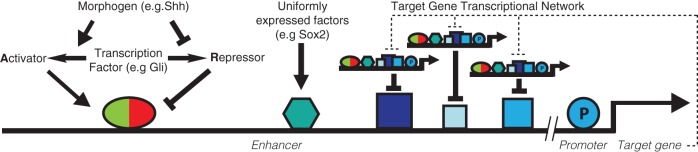
Model for morphogen target gene regulation. Shown is a morphogen-regulated gene in which an enhancer integrates the activity of three distinct classes of TFs. The activity of the MR-TF, which acts as a bifunctional activator-repressor, is determined by the level of morphogen signalling and provides positional information. Uniformly expressed TFs, exemplified by Sox2, are active throughout the tissue and contribute to the basal level of activity of a target gene. The target genes that are dynamically regulated downstream of the morphogen feedback into gene regulation. Each of these inputs can comprise multiple individual TFs with either inhibitor or activator function and the modelling framework is extendable to account for multiple inputs to a single gene.